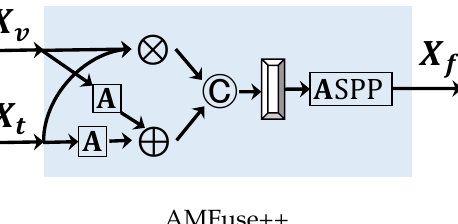
Figure 5. The illustration of AMFuse++ module, where A is the attention module and ASPP is the atrous spatial pyramid pooling module.